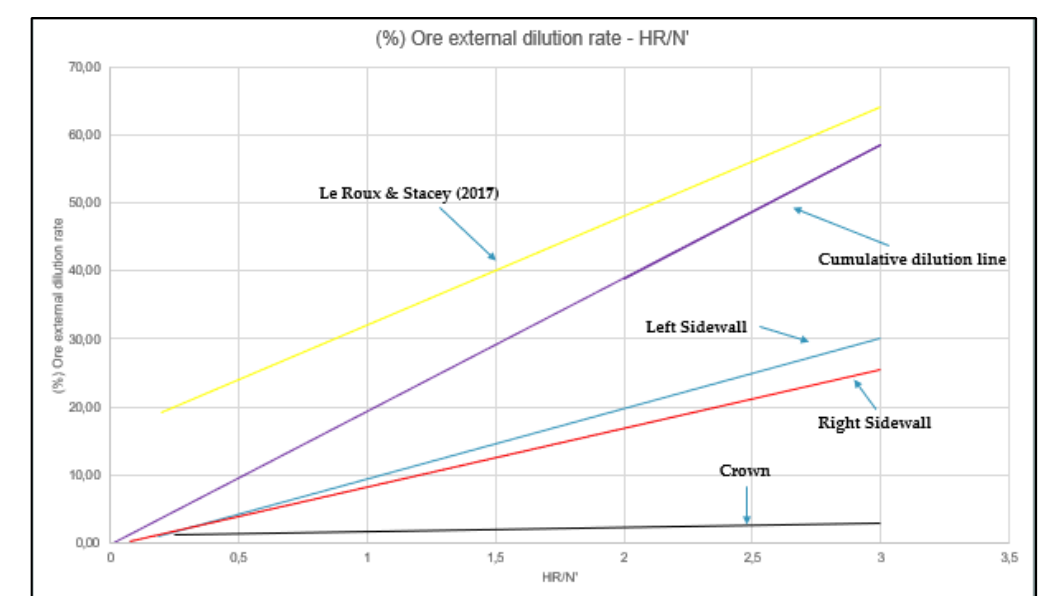
Figure 3. (%) Ore external dilution rate—HR/N’ diagram .